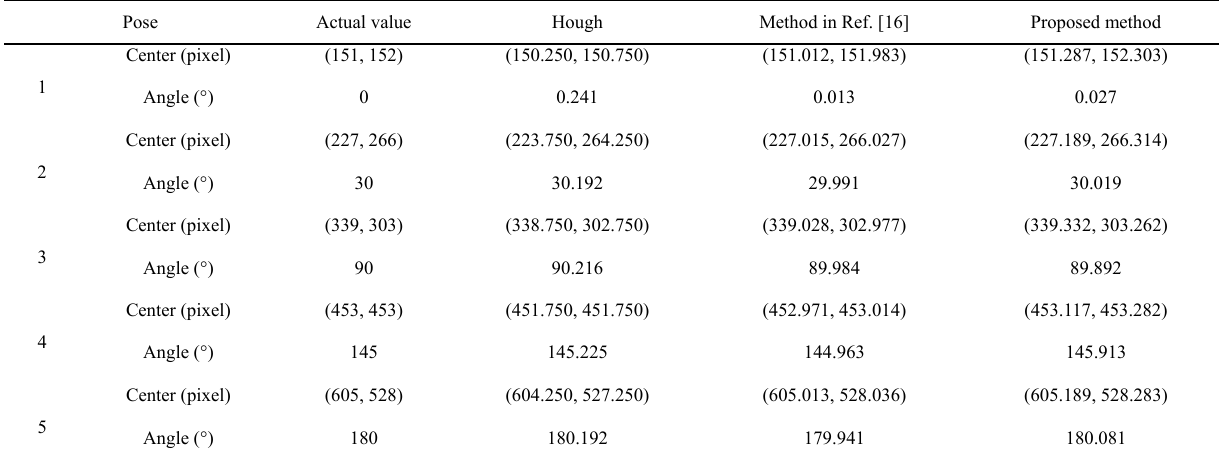
Table 2 Actual poses and calculated